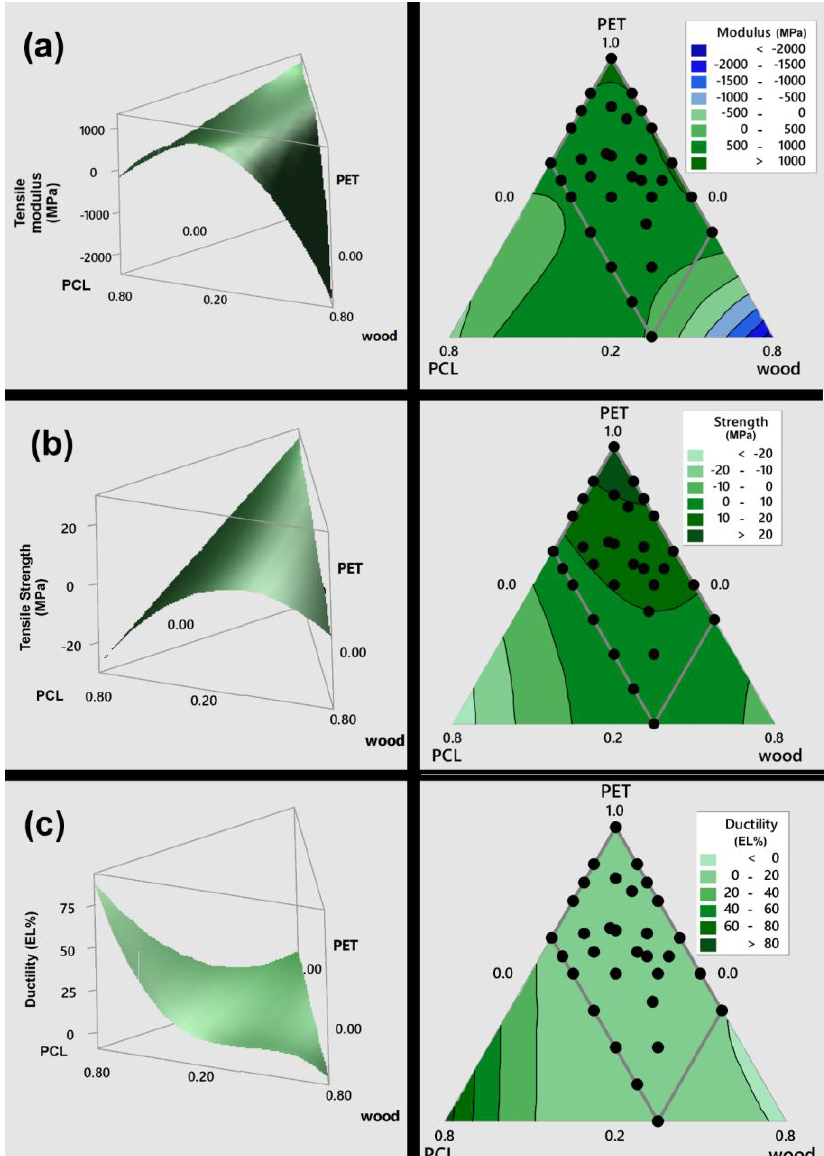
Figure 4. Mixture response surface and contour plots for effects of composition on rPET WPC mechanical properties: ( a ) tensile modulus, ( b ) tensile strength, and ( c ) ductility. Design space and design points are shown within the solid grey outline on the simplex coordinate system.